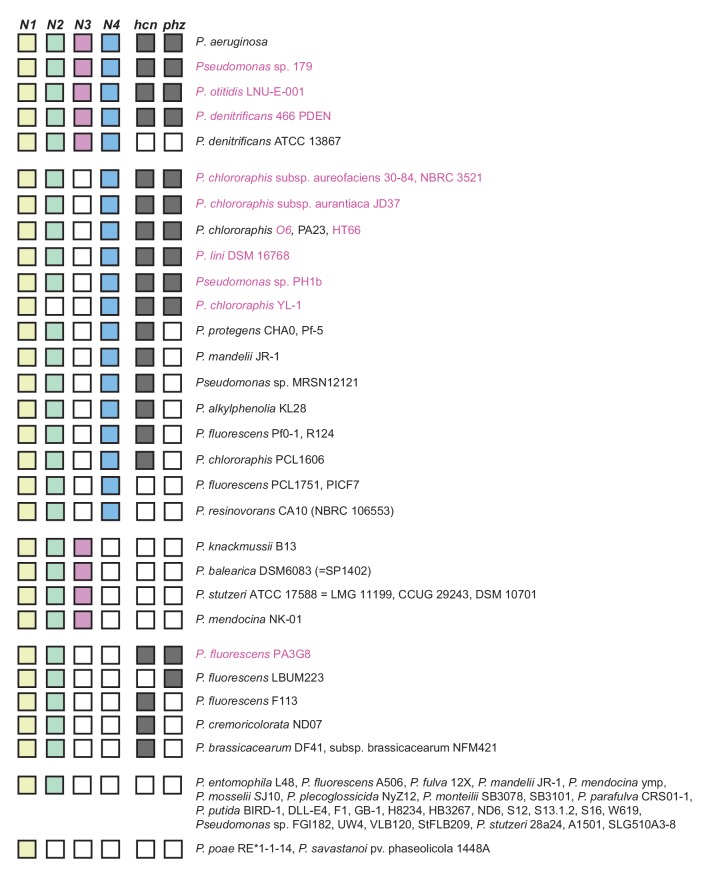
Pseudomonads with CcoN homologs.We examined genomes available in the Pseudomonas Genome Database (Winsor et al., 2016) for CcoN homologs by performing a protein BLAST search on CcoN1 from P. aeruginosa PA14. All hits from full genomes, excluding other P. aeruginosa strains, were aligned using ClustalW and a tree was built using the geneious tree builder (Geneious 10 (Kearse et al., 2012)). We also included draft genomes that contained genes involved in phenazine biosynthesis (highlighted in purple). The tree revealed four clusters, each being more closely related to one of the four N subunits from PA14, which allowed us to annotate the N subunits accordingly. We next probed all genomes with N subunits for the presence of genes involved in cyanide synthesis (hcnABC) and phenazine biosynthesis (phzABCDEFG). We did not find a clear correlation between the presence of CcoN4 and Hcn proteins (Hirai et al., 2016). We note that with the exception of two P. fluorescens strains, those containing phzABCDEFG operons also contained ccoN4.